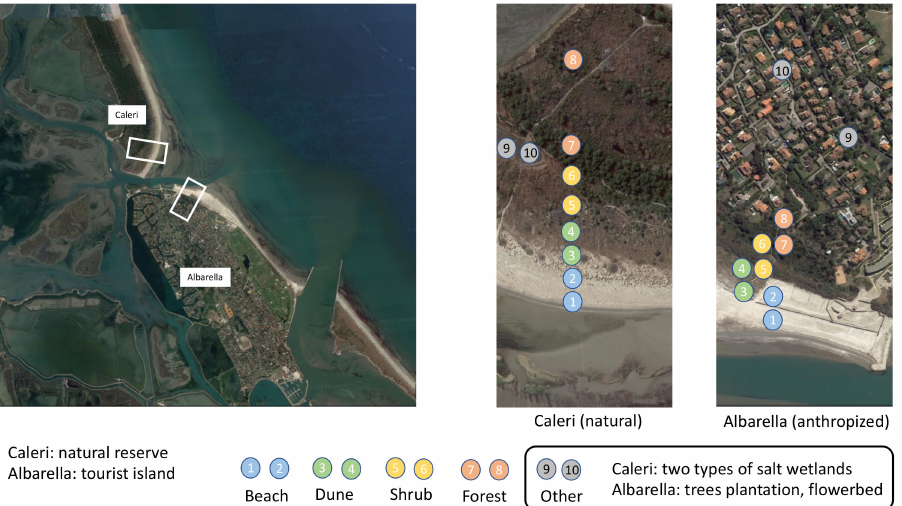
Figure 1. Sampling panel. The leftmost panel shows the symmetrical location and common geological and vegetational origin of the two opposite sites, Porto Caleri the natural reserve, versus Albarella, the touristic island. In both sites (center and rightmost panels), two series of samples were compared, belonging to five ecosystems (beach, dune, shrub, forest, and